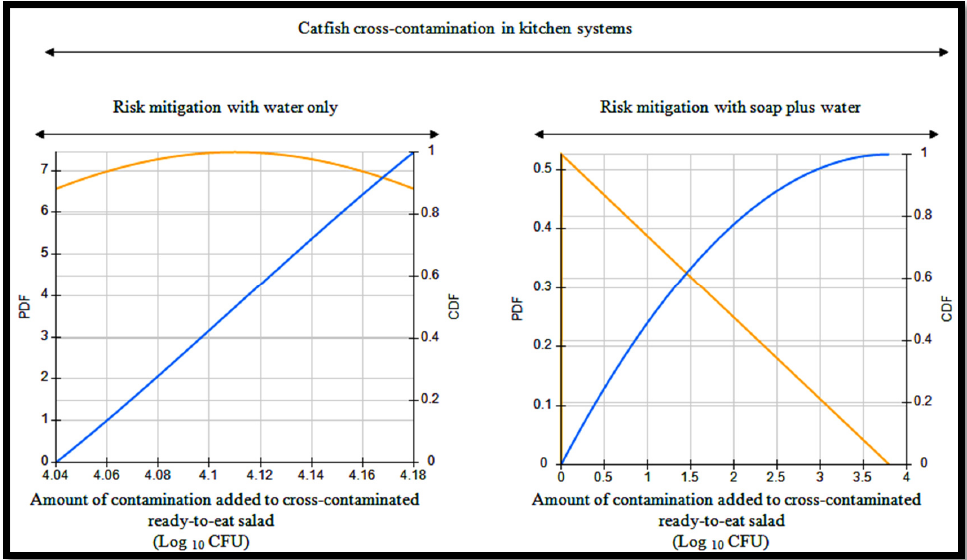
Figure 2. Probability distribution curves used in implementing the Monte-Carlo simulations used for the stochastic quantification of the variability in the concentration of multidrug-resistant AmpC beta- lactamase-producing Enterobacter cloacae pathogen in the cross-contaminated ready-to-eat salad. PDF (yellow line) represents probability density function. CDF (blue line) represents the cumulative distribution function. It was implemented with the FDA-iRisk version 4.0